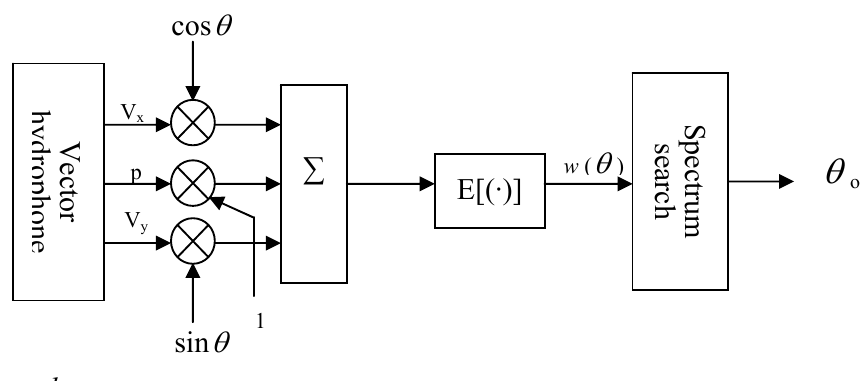
Figure7. Principle chart of the beam-forming